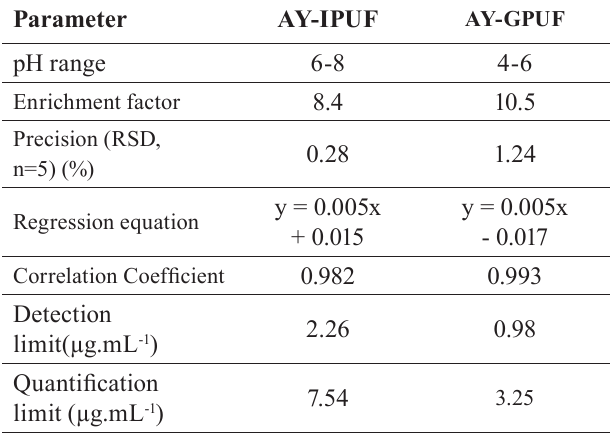
TABLE III - Analytical parameters of on-line preconcentration by AY-IPUF and AY-GPUF sorbents